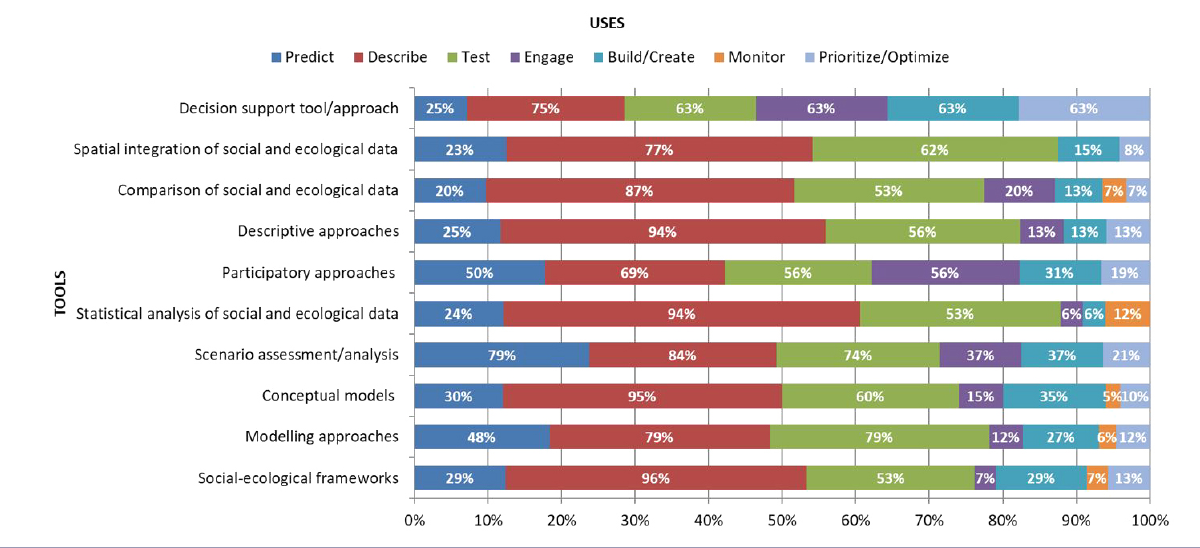
Fig. 2 . How different tools are being used or proposed to be used in social-ecological systems studies, as a proportion of the total number of studies found to apply each tool. A study can use a tool in more than one way.